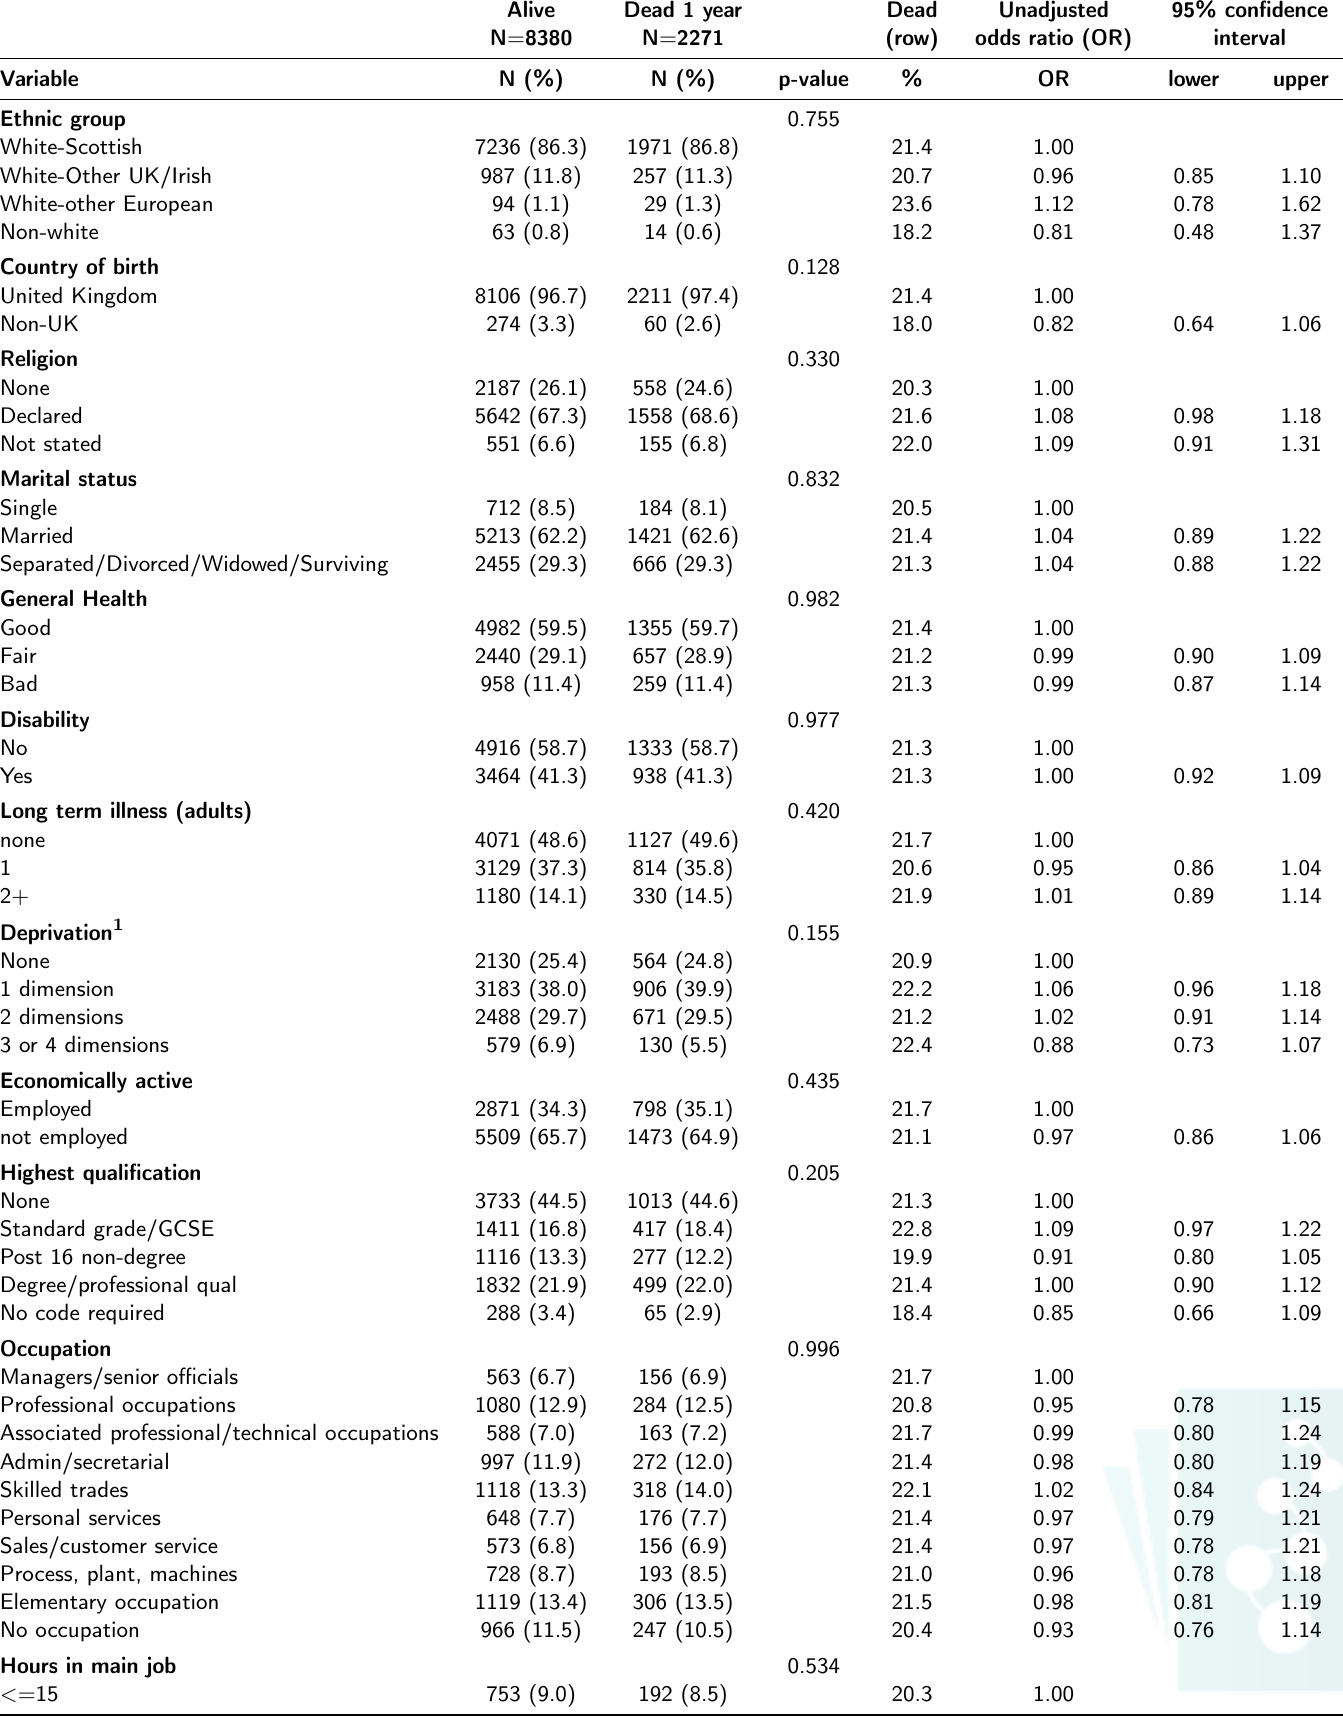
Table 5: Census characteristics by all cause one-year